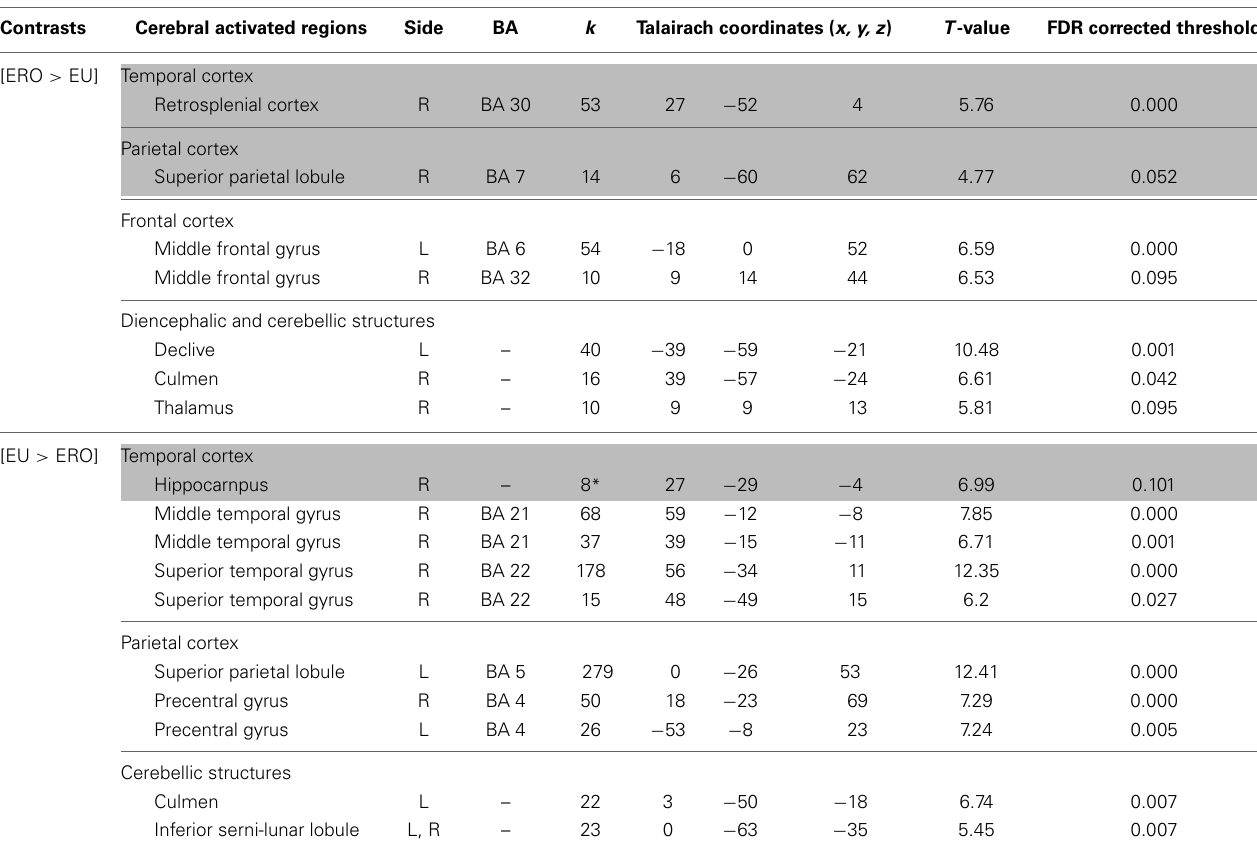
Table 4 | Activated regions for differential effects within two types of Egocentric spatial encoding, rotation changes vs. orientation and location